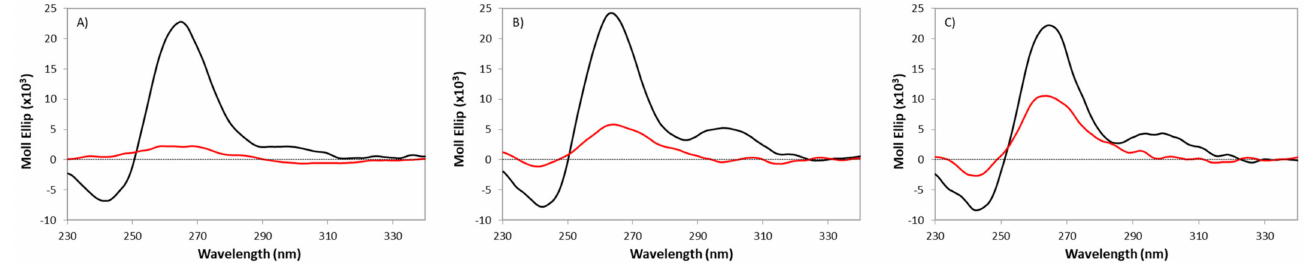
Figure 5. CD spectra of TERRA (5 µ M) in presence of 1 eq. of ( A ) Cu(ClO 4 ) 2 , ( B ) HP2Cu or ( C ) PE2Cu in 10 mM lithium cacodylate buffer at pH 7.4 with 100 mM KCl (black lines). In all the solutions, sodium ascorbate (1 mM) and H 2 O 2 (1 mM) were added, and CD spectra were recorded after 2 h reaction (red